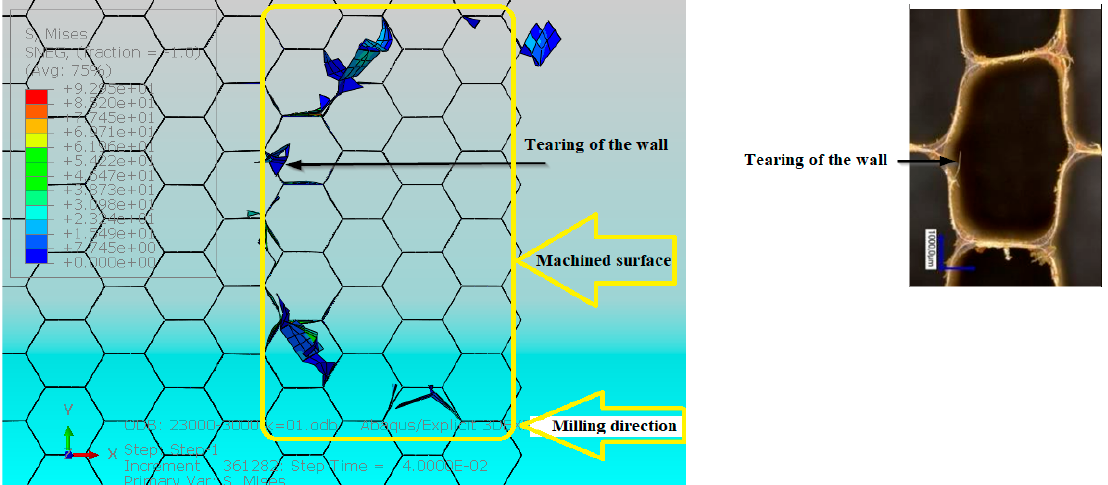
Figure 10. Comparison between the surface quality resulting from the numerical simulation and the surface quality determined from the experiment. The cutting conditions: 3000 mm/min and 23,000 rpm .